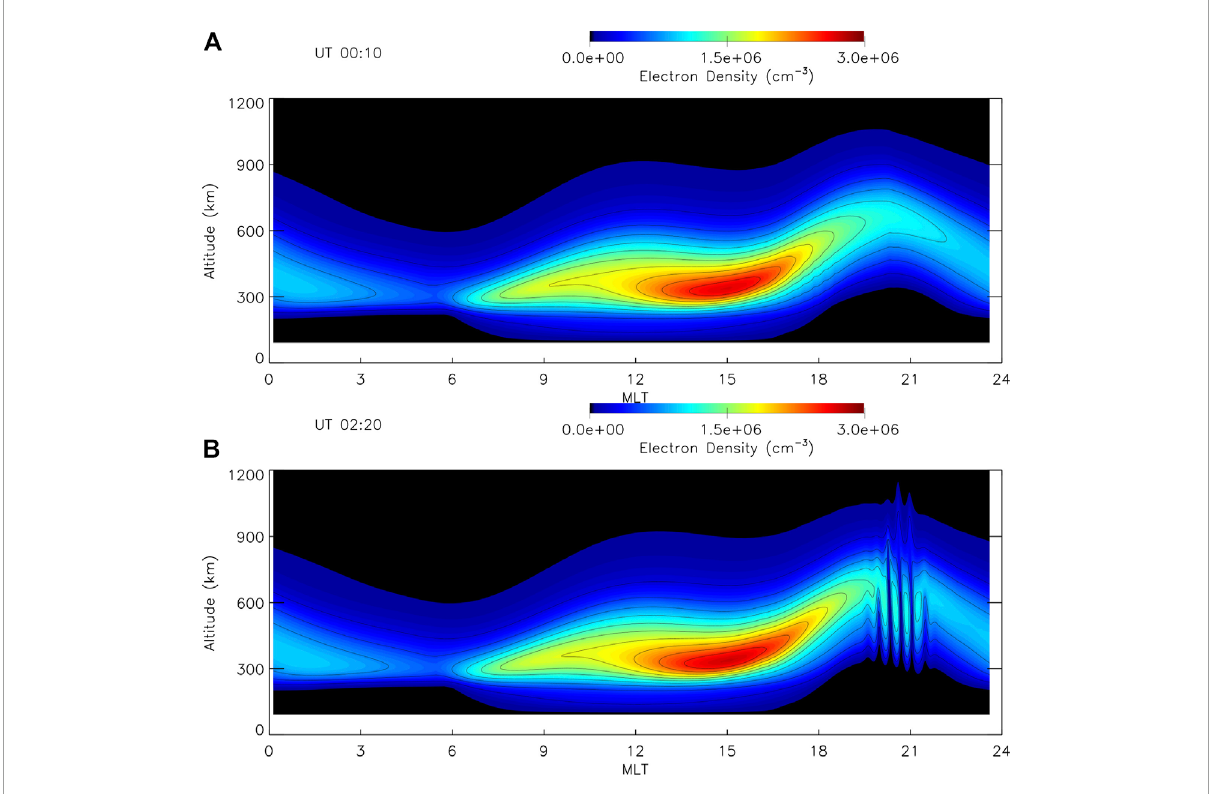
FIGURE 5 Electron density contours as a function of magnetic local time (MLT) and altitude (km) at 0 ° longitude are shown at times (A) 00:10 UT and (B) 02:20 UT (from Huba and Joyce,